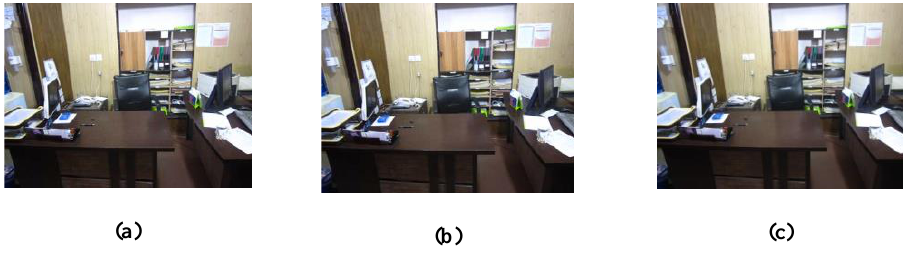
Figure 16. Virtual view synthesis by different methods for "office 2" (a) the virtual view by the method used in [16] considering n=5 , (b) the virtual view by the proposed method considering n=5 , Table 10. Comparison of the proposed method with the method used in [16] for "Office 1" and "Office 2".